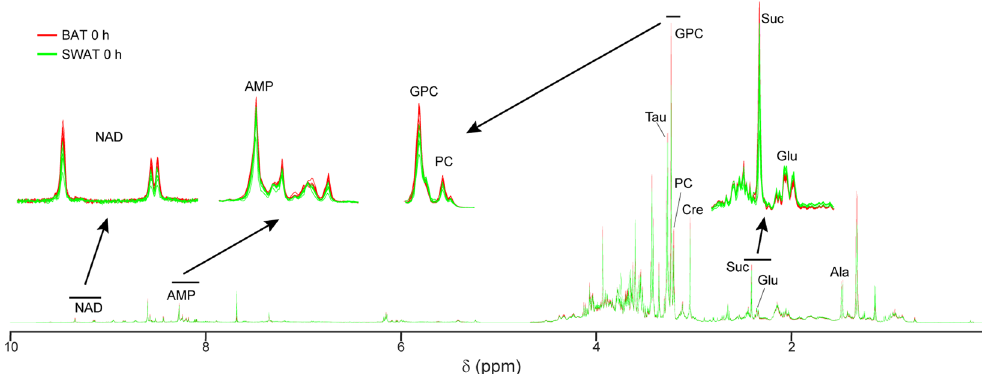
Figure 2. MRS metabolic profiles of BAT and SWAT samples at thermoneutrality. The MRS spectra acquired on BAT (red lines) and SWAT (green lines) samples (6 replicates each) are shown. Resonances of selected biomarkers are magnified above the full spectrum. NAD: nicotinamide adenine dinucleotide; AMP: adenosine monophosphate; TAU: taurine; GPC: sn-glycero-3-phosphocholine; PC: phosphocholine; Cre: creatine; Suc: succinate; Glu: glutamate; Ala: